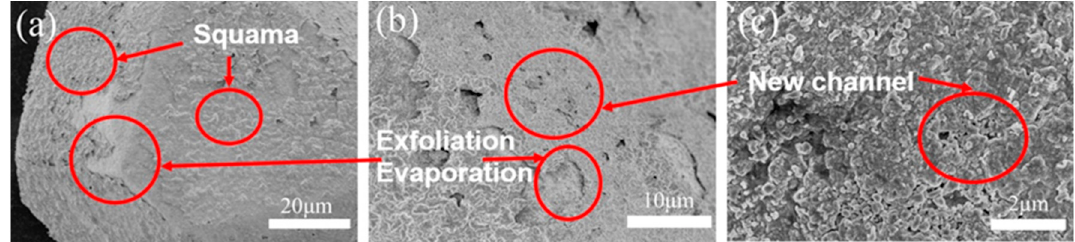
Figure 8. SEM images for Cr–B–C coated diamond after annealing at 1151 °C: ( a ) the squama on diamond surface; ( b ) the exfoliation and evaporation of coating; ( c ) the new channel for oxygen.